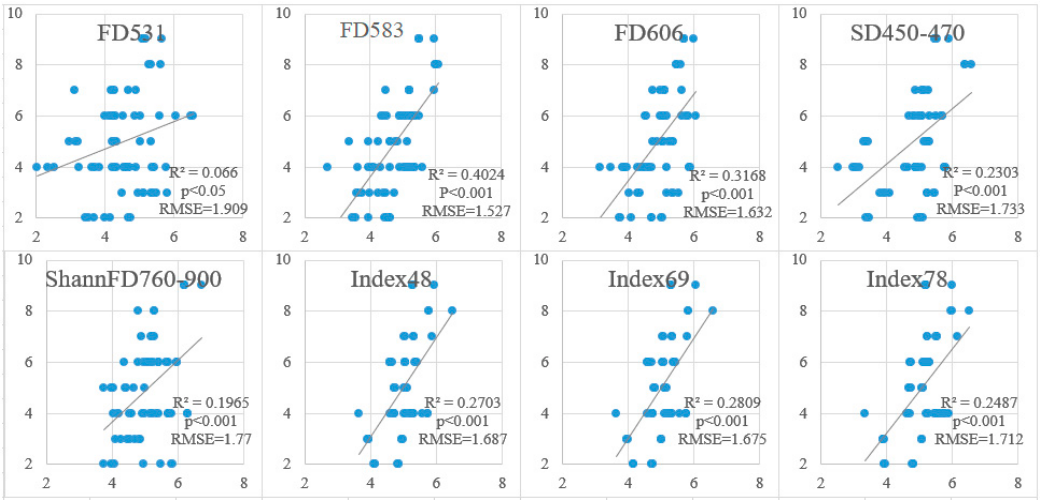
Figure 5. Linear regression of the field-measured values ( y -axis) and predicted values ( x -axis) for plant species richness based on validating dataset in the central Hunshandak Sandland, northern China (n = 75). Predicted values were calculated based on the best models that are listed in Table 3.